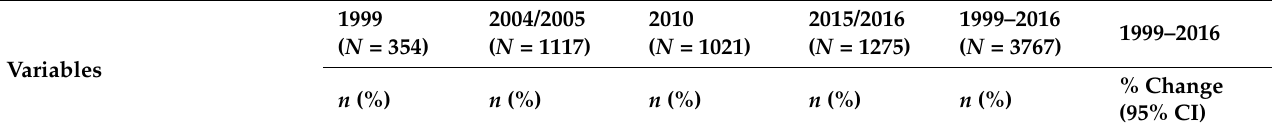
Table 2. Prevalence of unmet need for birth